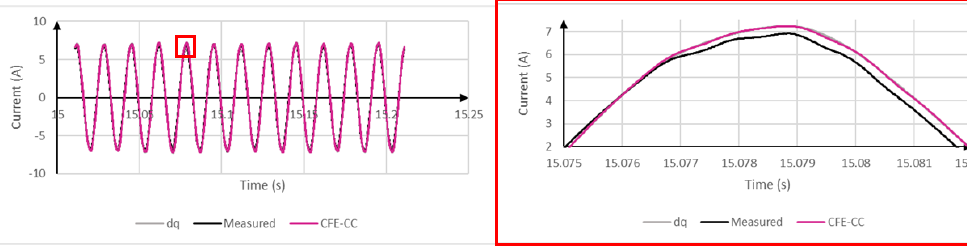
Figure 7. Stator current in winding a s during load operation, enlarged on right side.